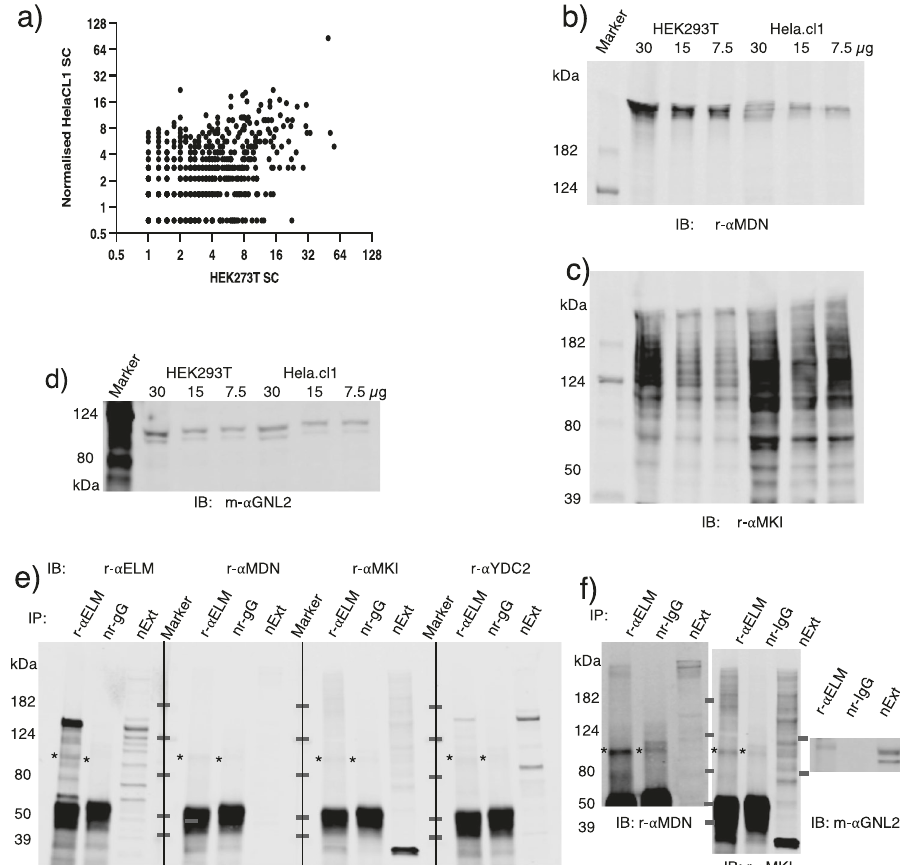
Fig. 6 RNAmetasome network of Hela.cl1. a Scatter diagram of the RNAmetasome network proteins. X and Y axes show net spectral count (SC) of the HEK293T and the Hela.cl1 proteins immunoprecipitated with the anti-ELMSAN1 antibody. Net SC of HEK293T = average of total SC − average of four control SC; likewise, net SC of Hela.cl1 = total SC − control SC. Net SC of HEK293T and Hela.cl1 were 14 and 10, respectively. In this diagram, 631 proteins are plotted after the Hela.cl1 ’ s values are normalized by factor 14/10. r = 0.47, P < 0.0001. b – d MDN1, MKI67, GNL2 level of HEK293T and Hela.cl1 nuclear extracts estimated by western blotting. e IB of proteins immunoprecipitated with the anti-ELMSAN1 antibody. All procedures for these experiments were carried out in parallel, which reveals that MDN1 is at an undetectable level. This ELMSAN1 IB image (far left) is fl ipped and presented in Fig. 1f (left). f High- intensity scanned image of e and